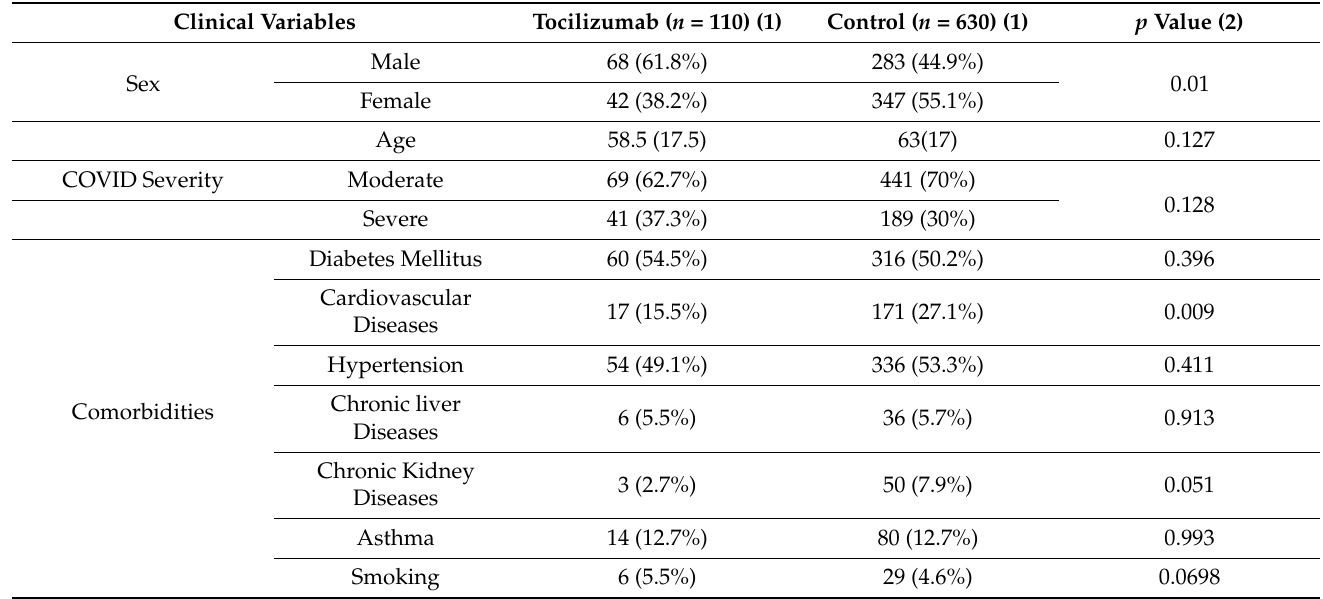
Table 1. Baseline clinical variables of the study population.